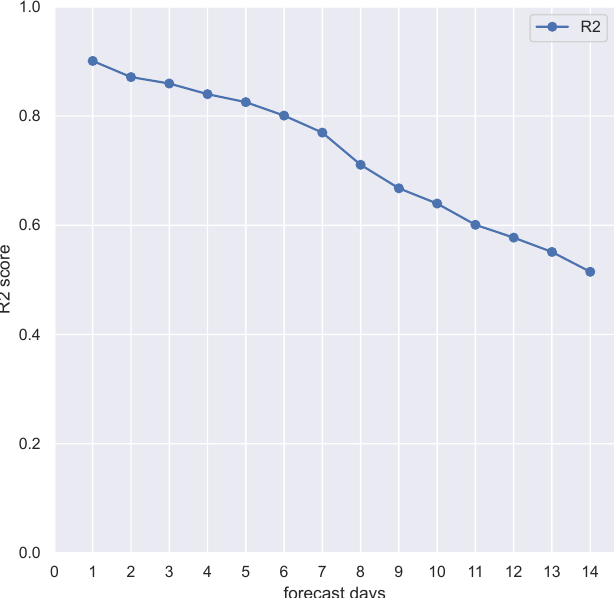
Figure 8. Pooled R 2 scores of the 14-days out-of-sample forecast of COVID-19 new daily cases in Calabria (Italy) with SARIMA